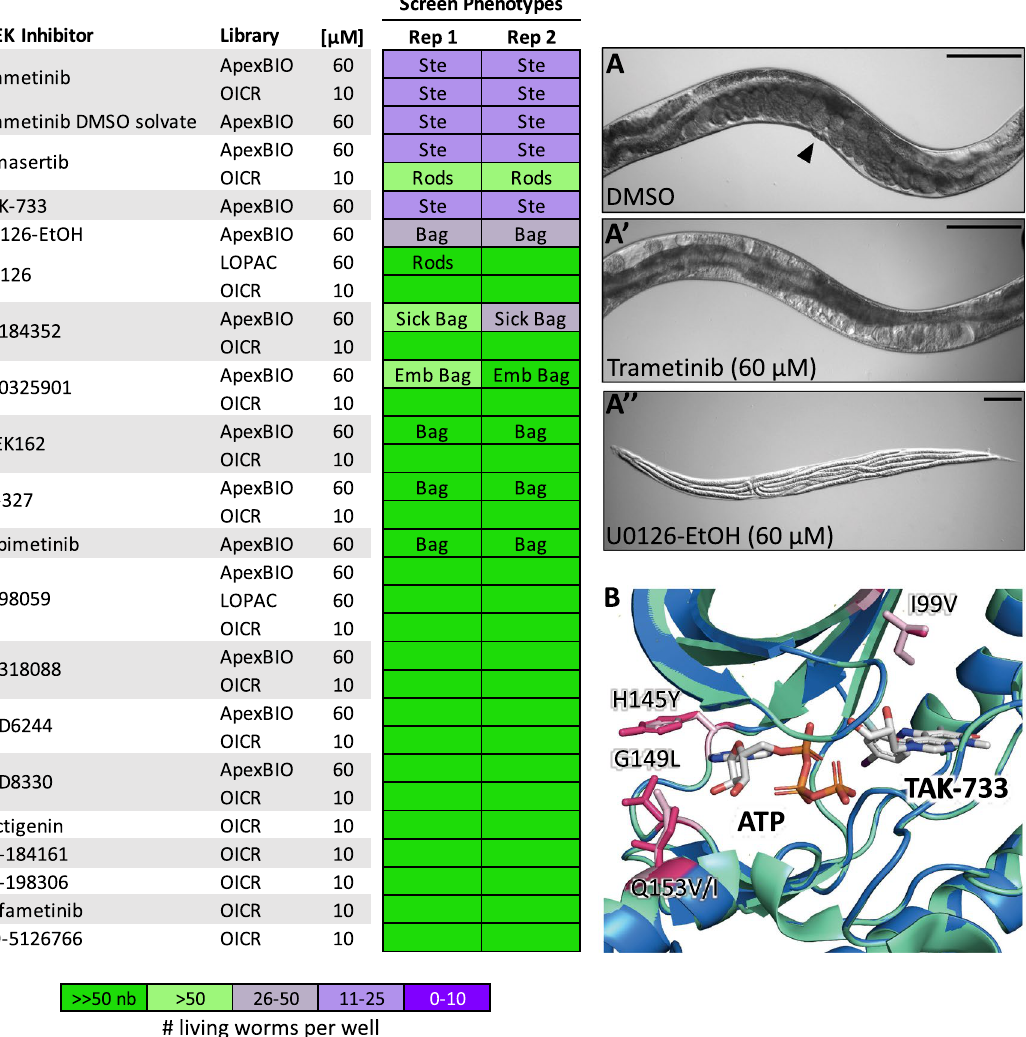
Figure 6. Allosteric MEK inhibitors induce sterility, embryonic lethality and vulva development phenotypes in C. elegans. 18 unique MEK inhibitors from the commercial libraries screened were included in our screen. These inhibitors were enriched for hits that induce the expected MEK-2 loss-of-function phenotypes including sterility (Ste) and the bag-of-worms phenotype (Bag), resulting from vulval induction defects preventing egg-laying ( A-A ′′ , scale bar 0.1 mm). The resulting population growth defects are indicated by the colour coded scale (nb, no bacteria remaining in the well). ( B ) The allosteric inhibitor binding site of C. elegans MEK-2 (in blue) is well conserved with that of vertebrate MEK1 (in green, seen co-crystalized with allosteric inhibitor TAK-733 (PBD: 3PPI). The allosteric site contains only one amino acid difference, highlighted in pink